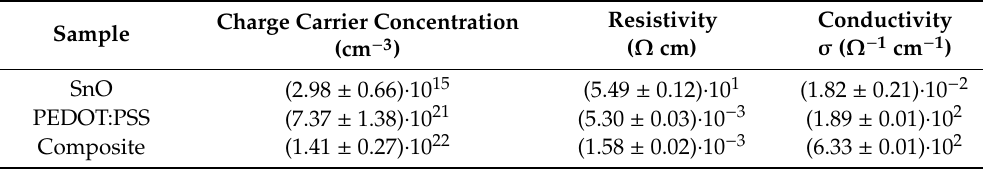
Table 1. Hall e ff ect measurements performed with I = 0.1